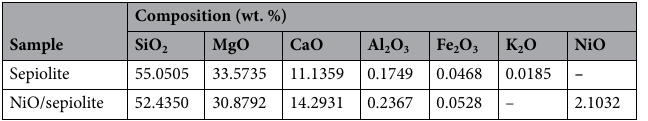
Table 1. Chemical composition of sepiolite and NiO/sepiolite (derived from XRF analysis).